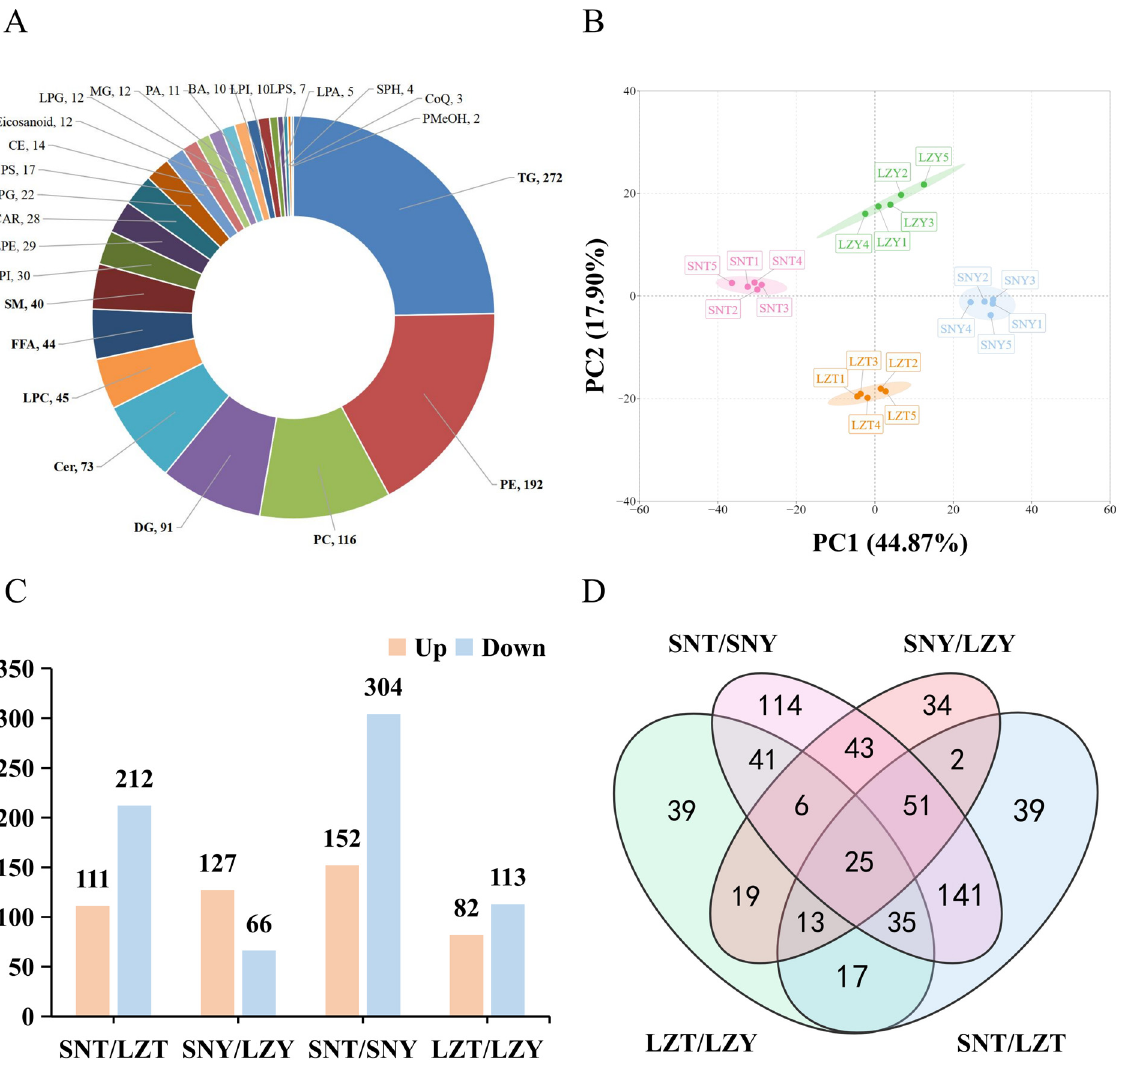
Figure 1. Lipidomic analysis of the pig liver of different breeds raised at different altitudes. ( A ) Number of lipids for the 25 lipid subclasses identified in the LZT, SNT, LZY, and SNY groups. ( B ) Principal component analysis (PCA). ( C ) The number of differentially abundant lipids (DALs) obtained by comparisons between two groups. ( D ) Venn diagram of the DALs distribution.